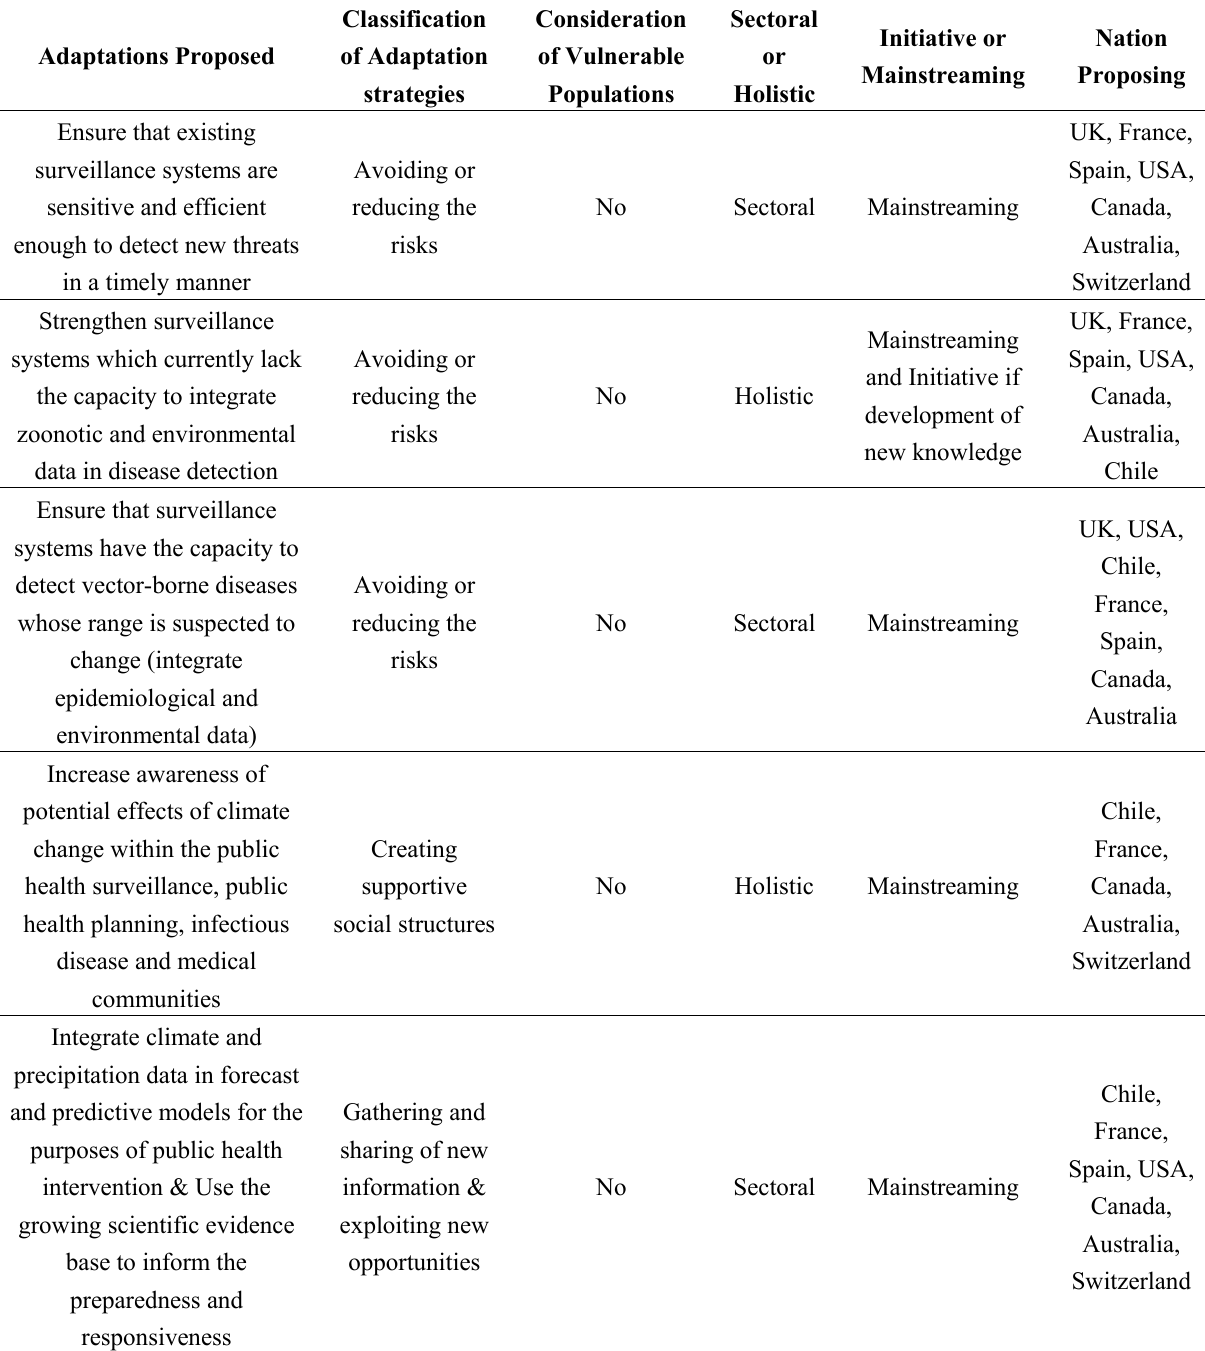
Table 6 . Specific types of adaptations to infectious disease risks of climate change proposed within reviewed documents and classification of adaptation options according to Preston et al. ’s (2011) [29] proposed